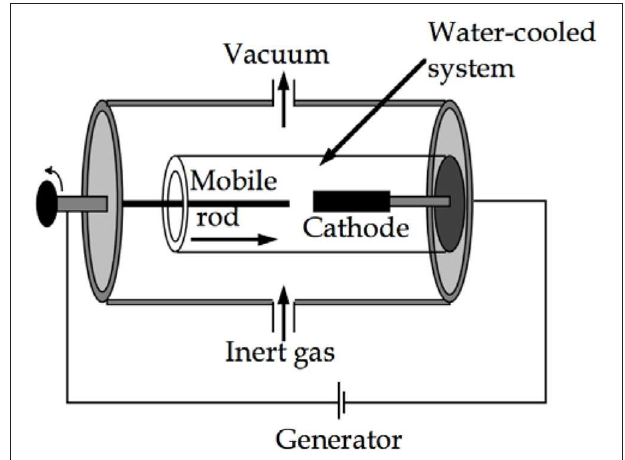
FIGURE 1 | Schematic progress of CNT formation by arc-discharge method (Journet and Bernier, 1998).